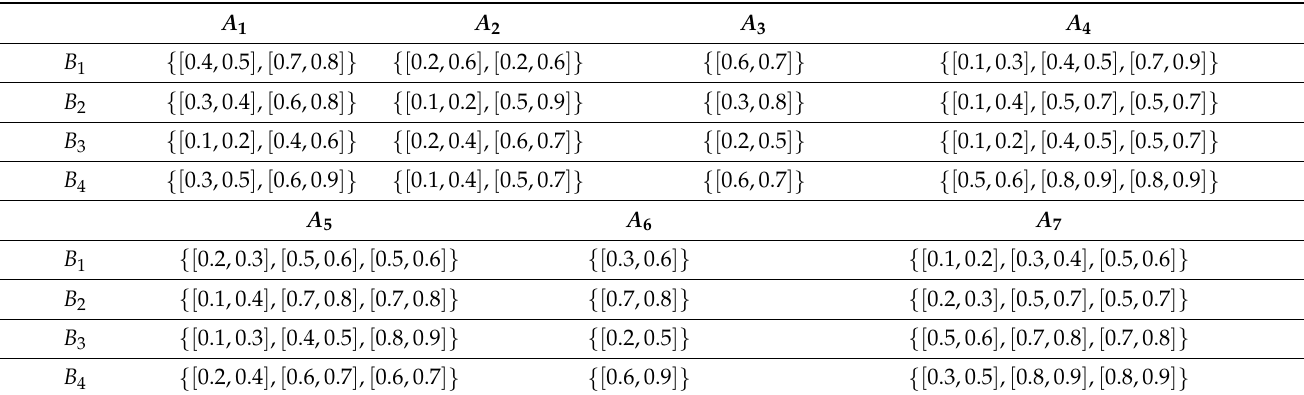
Table 5. Interval-valued hesitant fuzzy preference matrix